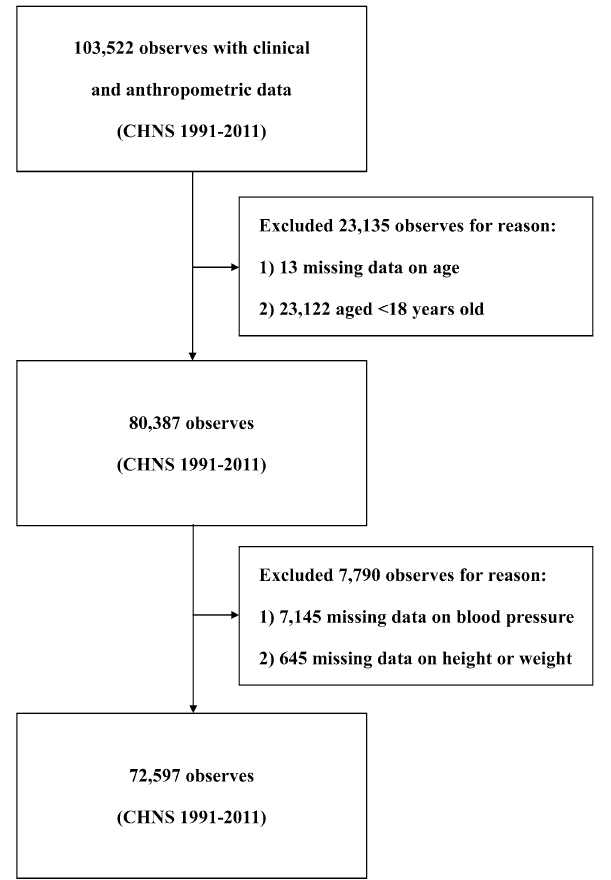
Figure 1. Flow chart illustrating the sample selection for the present